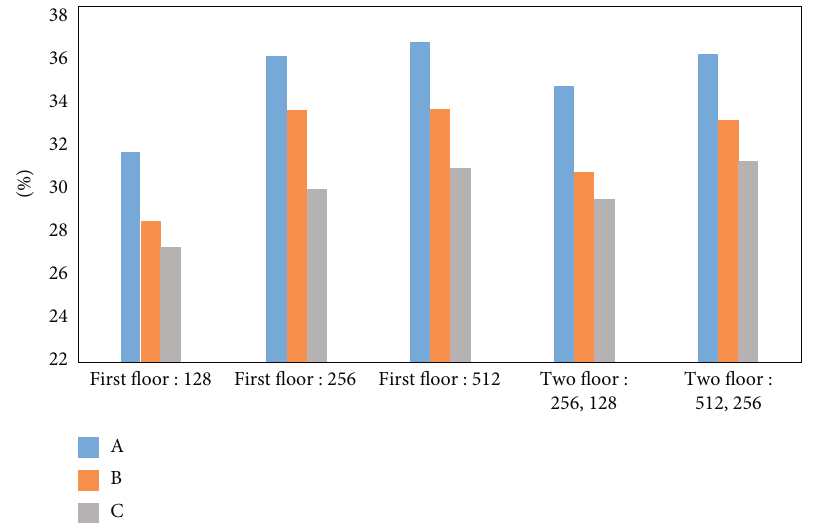
Figure 6: Experimental results of GRU under di ff erent parameter